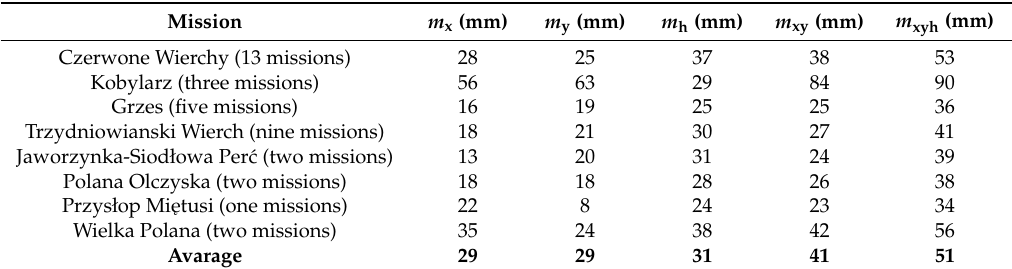
Table 3. Final mean square errors of points coordinates of the photogrammetric